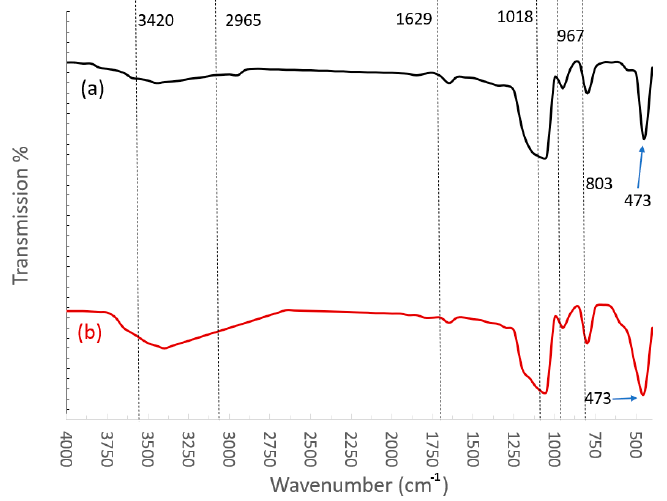
Figure 5. FT-IR spectrum of ( a ) HMDS capped nano-silica ( b ) After Plasma treatment.